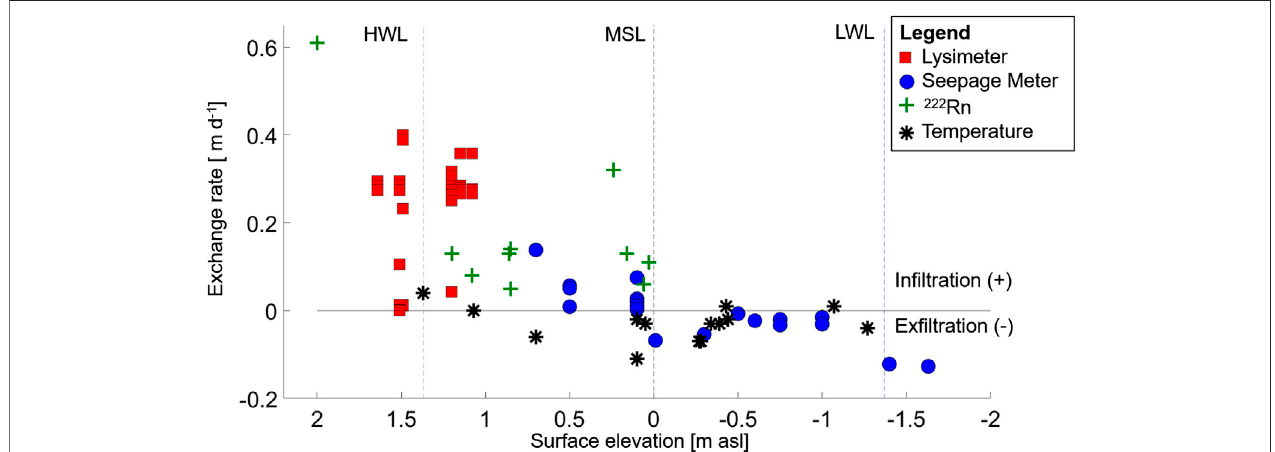
FIGURE 3 | Measured exchange rates plotted vs. surface elevation. Positive rates indicate in fi ltration and negative rates ex fi ltration. The different techniques are illustrated with red squares (lysimeters), blue circles (seepage meters), green crosses ( 222 Rn), and black stars (temperature sensors). Mean HWL (red), MSL (black), and mean LWL (blue) are shown as dashed lines.